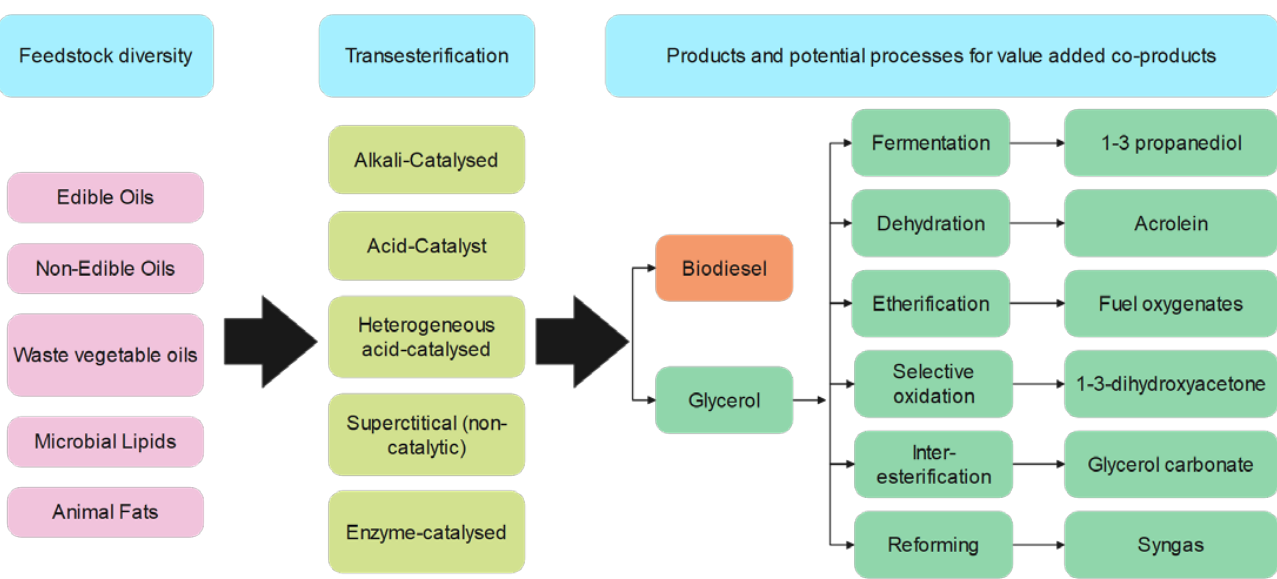
Figure 1. Schematic representation of transesterification process technology and feedstock options for biodiesel production (redrawn and modified from Pasha et al. [43].)